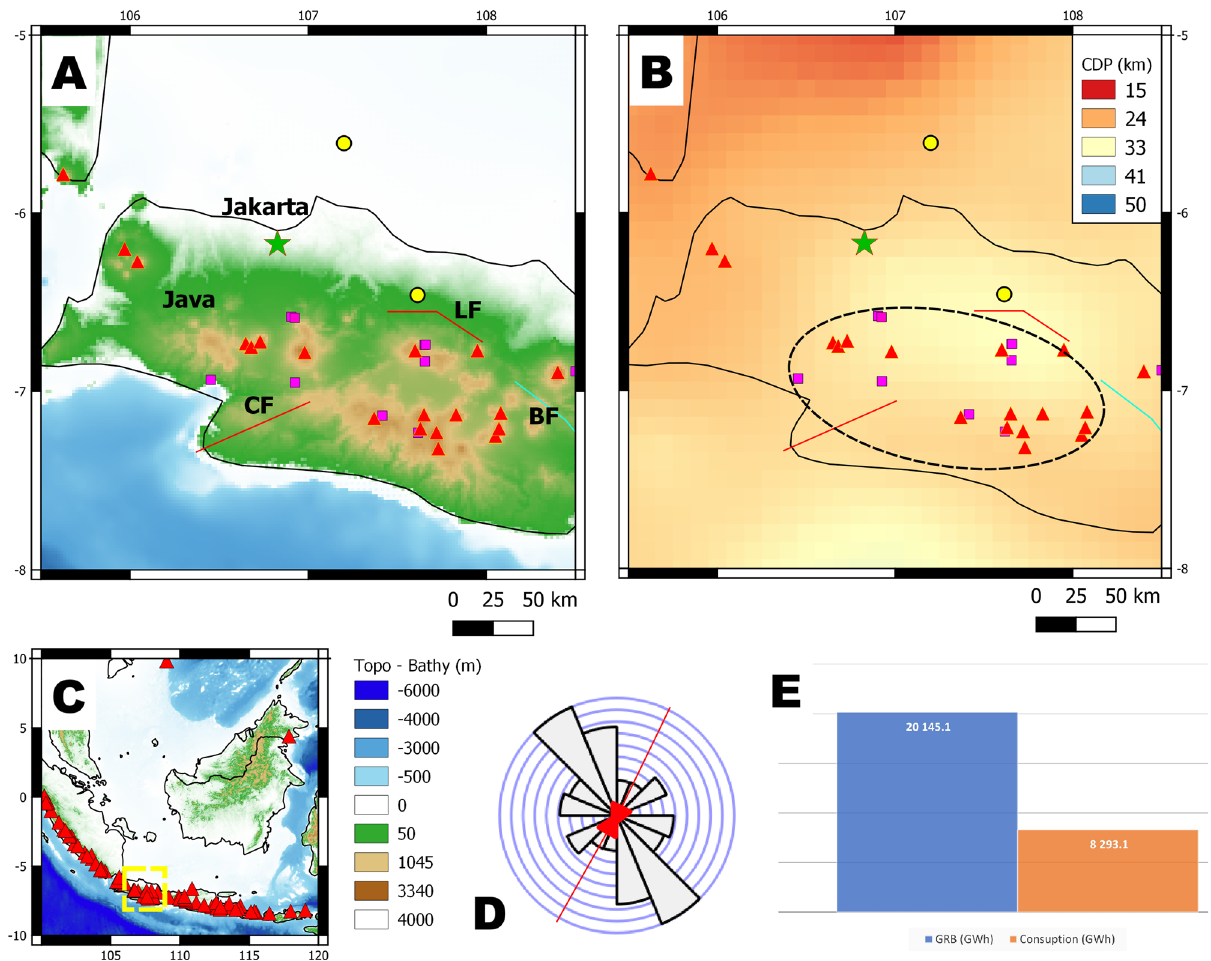
Fig. 4 Geothermal system of Jakarta. A Spring water distribution (purple squares) in the area of Jakarta. B Calculation of the Curie Point Depth (CPD) in the area north of Bogotá 54 . Black-dashed ellipse represents a hypothetical envelope encompassing the main geothermal leads. Maps display normal faults (blue lines), reversal faults (red lines), right-lateral faults (cyan lines), left-lateral faults (yellow lines), active volcanoes (red triangles), and O&G fi elds (yellow dots). Topography from Amante and Eakins 59 . Black-dashed ellipse corresponds to the hypothetical envelope that encompasses the main geothermal lead. C Study area in a regional context; D Rose diagram showing regional fault trending and the maximum principal stress direction (red arrows showing compressive regime); Rose diagrams are expressed in eight intervals of azimuth to the respective length of faulting. E Comparison between the potential geothermal power expressed as GRB (estimated in this work) and the current energy consumption in the metropolitan area of Jakarta. Coordinate system in